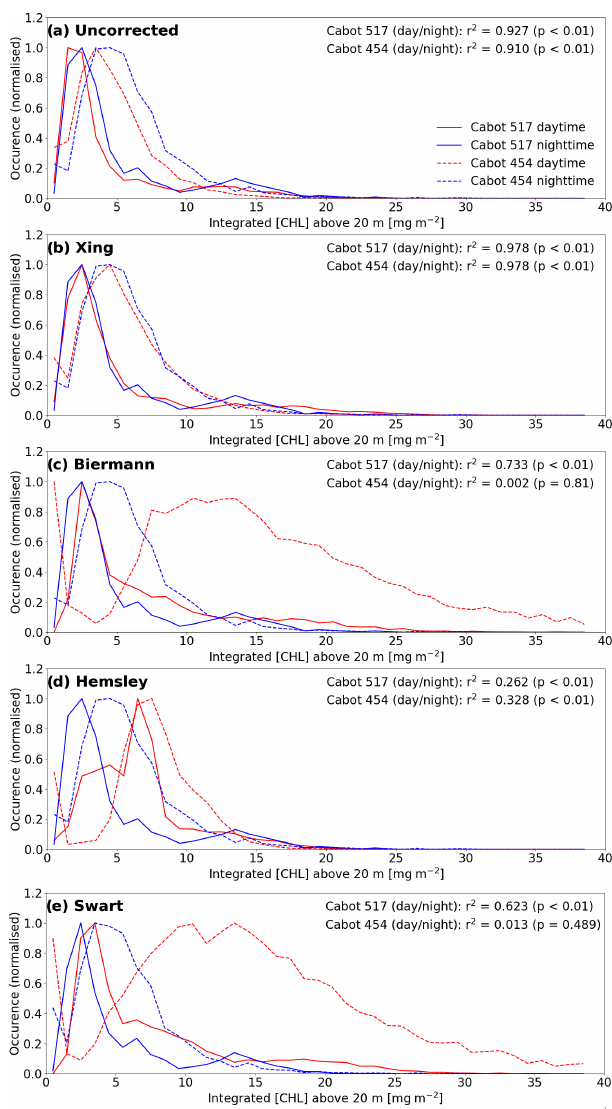
Figure 5. The effects of the implementation of different quench- ing mechanisms on the distribution of the integrated [Chl- a ] in the top 20m for Cabot deployments 454 (dashed lines) and 517 (solid lines). Panel (a) shows the distribution of daytime (red) and night- time (blue) [Chl- a ] in the uncorrected case. Panels (b) , (c) , (d) , and (e) show the effects of implementing the mixed-layer-depth-based correction of Xing et al. (2012), euphotic-depth-based correction of Biermann et al. (2015), and the backscatter-based corrections of Hemsley et al. (2015) and Swart et al.